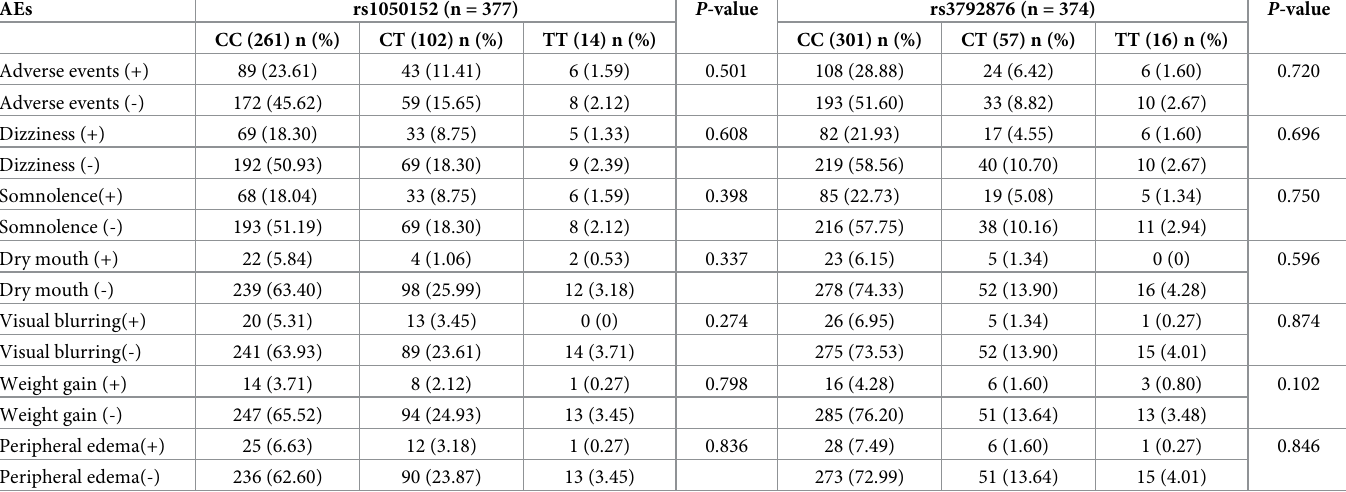
Table 4. Adverse events (AEs) in patients with OCTN1 rs1050152 and rs3792876 gene